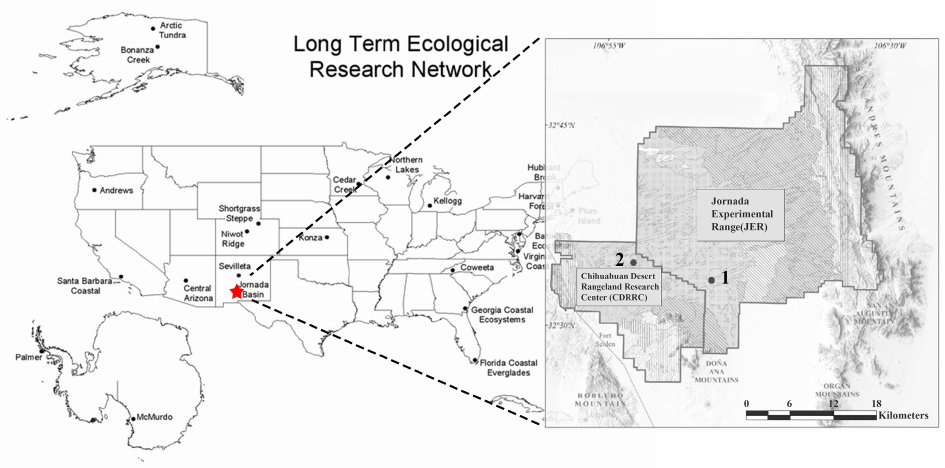
Figure 1. The Long Term Ecological Research Network. The location of the Jornada Basin is shown with a red asterisk. Site 1 and site 2 are the locations of the study sites in this